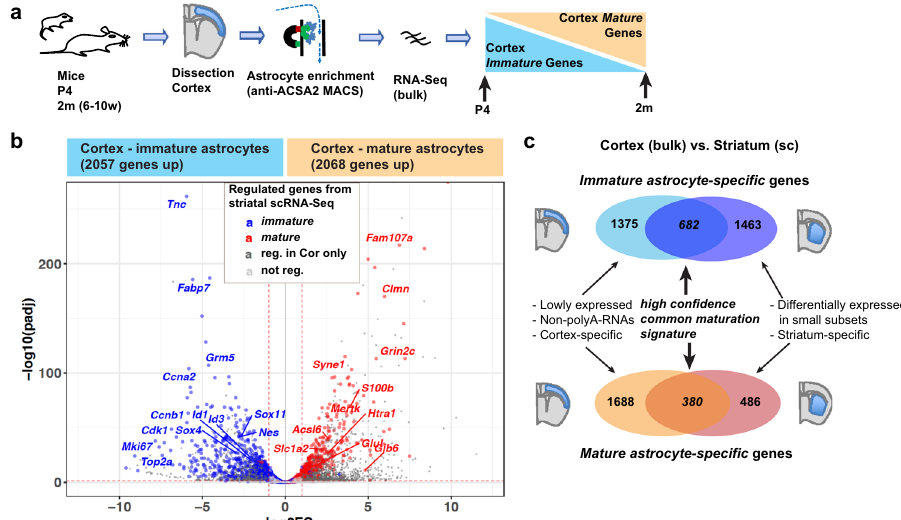
Fig. 2 Comparison of striatal and cortical datasets reveals a common astrocyte maturation signature. a Approach used for MACS (magnetic bead assisted cell sorting) enrichment and bulk RNA-Sequencing (RNA-Seq) analysis of immature astrocytes from postnatal day 4(P4) cortex and of mature astrocytes from adult cortex (age 2 months (2m), range 6 – 10 weeks (6 – 10w)). b , c Volcano plot ( b ) and Venn diagrams ( c ) show genes differentially expressed between cortical astrocyte preparations from P4 and adult brain. Maturation-regulated genes identi fi ed by scRNA-Seq of striatal astrocytes (see Fig. 1f) are highlighted in ( b ). Venn diagrams ( c ) show overlap of genes signi fi cantly regulated between early postnatal and adult astrocyte preparations in both striatal scRNA-Seq and cortical bulk RNA-Seq datasets. Biological and technical differences between the analyses may contribute to the differences in genes detected in the two datasets, as indicated in ( c ). Differential genes: DESeq2 analysis, each n = 3; two-sided Wald test with Benjamini – Hochberg correction; signi fi cance threshold: adjusted p -value (padj) ≤ 0.05, absolute log2(fold change)(log2FC) ≥ 1.See also Supplementary Data